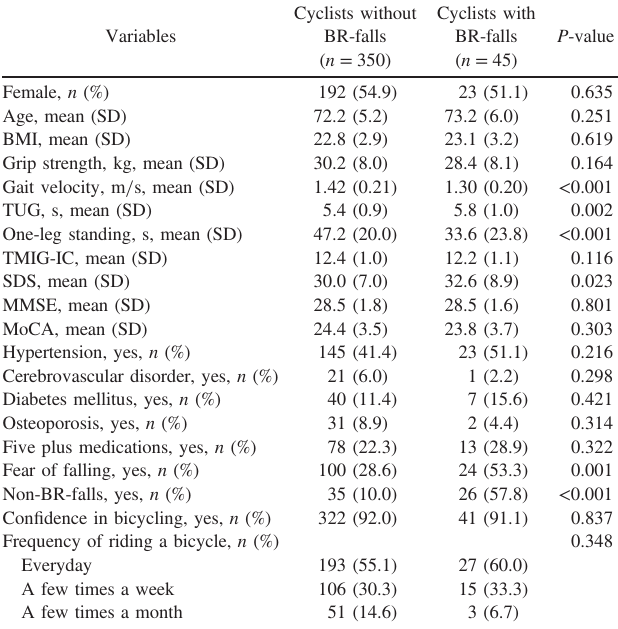
BMI, body mass index; MMSE, Mini-Mental State Examination; MoCA, Montreal Cognitive Assessment; Non-BR-falls, fall history in previous year without bicycling; SD, standard deviation; SDS, Zung Self-Rating Depression Scale; TUG, timed up & go; TMIG-IC, Tokyo Metropolitan Institute of Gerontology Index of Competence. Table 2. Logistic regression analysis of factors associated with the experience of bicycle-related falls (BR-falls) Variables OR (95% CI) P -value Gait velocity, one m = s decrement